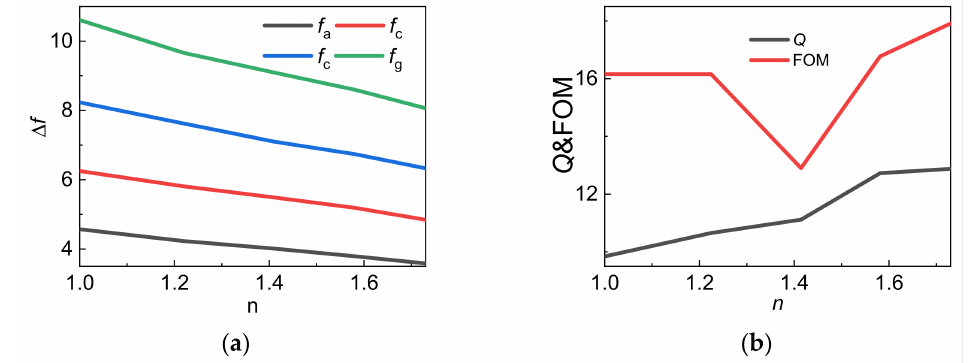
Figure 12. ( a ) Frequency shifting of f a , f c , f e , f g on n from 1.0 to 1.73, ( b ) FOM and Q varied with n from 1.0 to 1.73.